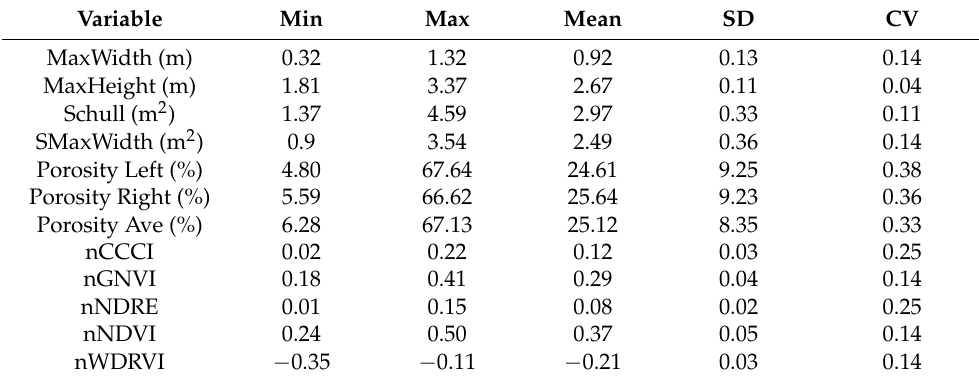
Table 2. Basic descriptive statistics of the analyzed variables (N = 4027).